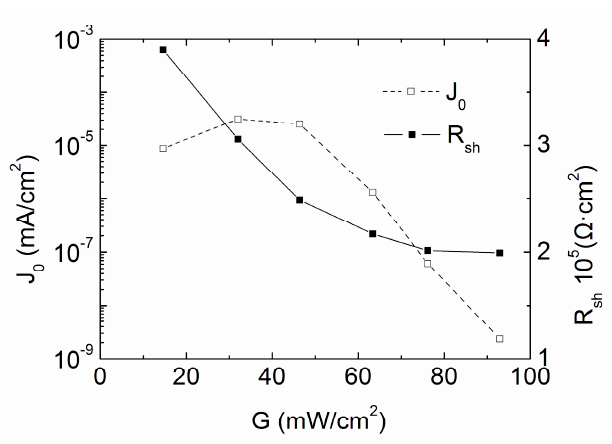
Figure 7. Intensity G versus J 0 and R sh under low intensity illumination condition for cell #1.